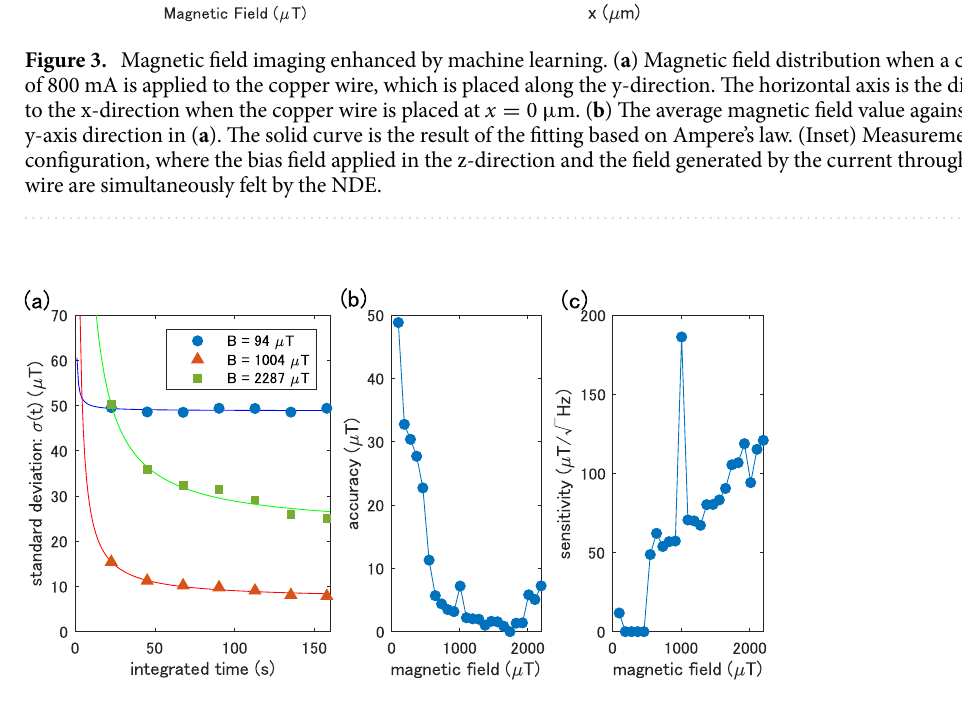
Figure 4. Accuracy and sensitivity of nanodiamond quantum sensors. ( a ) Standard deviation of the difference between the true and the predicted magnetic field from the test data. The horizontal axis is the measurement time for test data. ( b , c ) Magnetic field dependence of ( b ) accuracy and ( c ) sensitivity obtained by fitting of ( a ). An outlier near 1000 µ T is due to an accidental artifact in the analysis in terms of low signal-to-noise ratio (Section S5in Supplementary